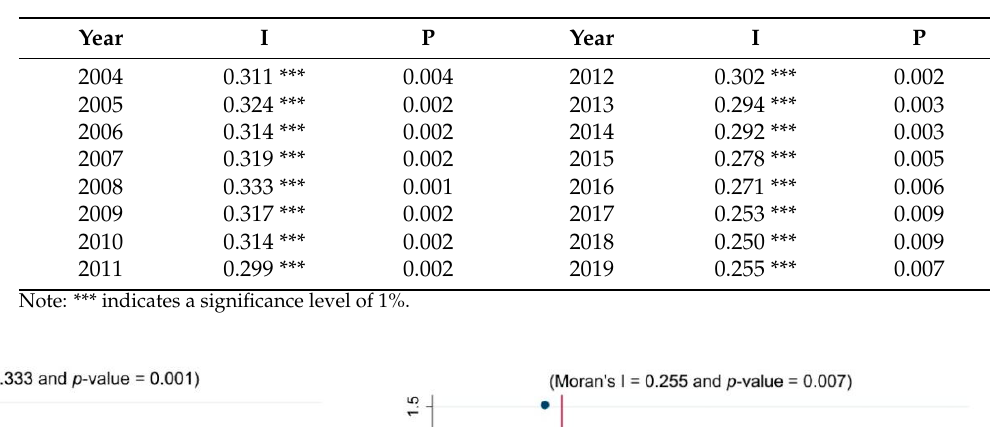
Table 3. Moran’s index of CO 2 emissions.